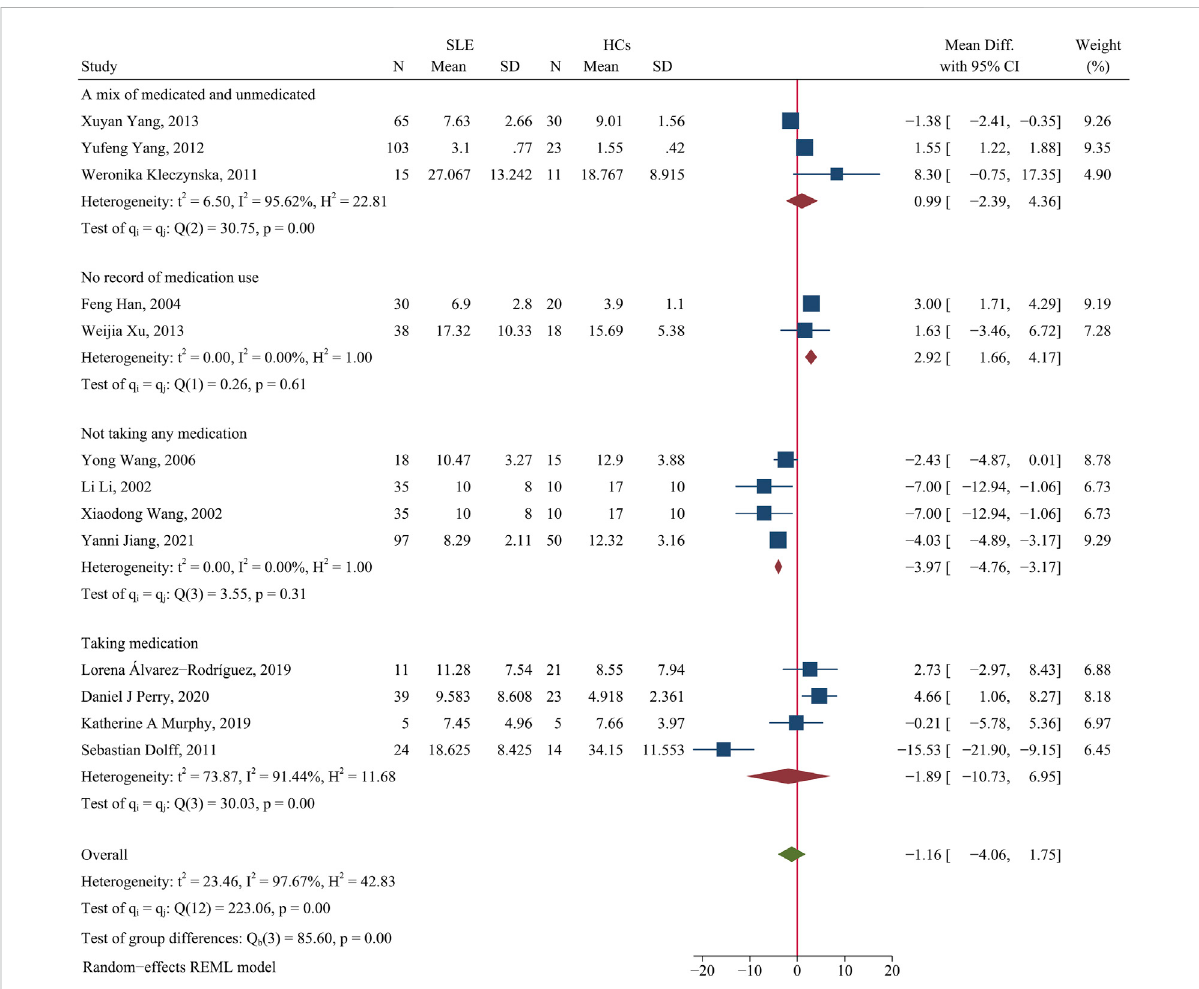
FIGURE 1 Forest plot of the percentage change of Th1 cells in SLE patients compared with HCs. The overall results (bottom) show the meta-analysis of 13 studies, and the other four results show meta-analyses of different subgroups according to medication use. SLE, systemic lupus erythematosus; HCs, healthy